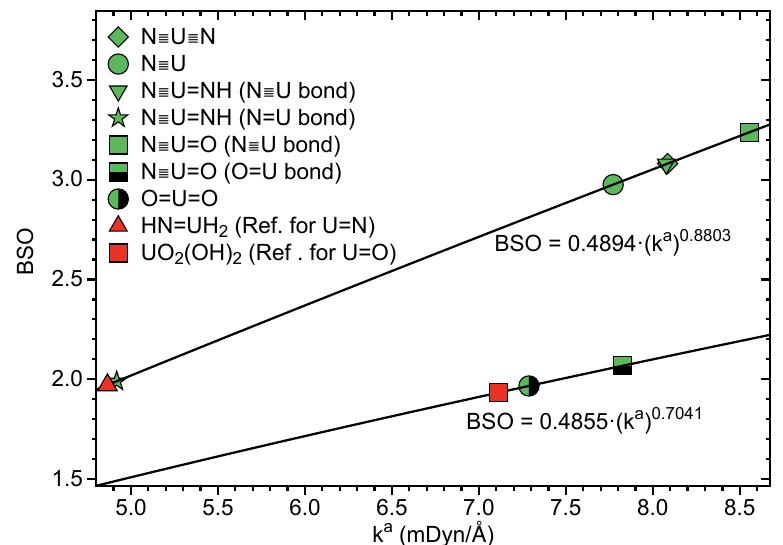
Figure 4. BSO values of UN bonds for the selected uranium nitrides derived from k a values via the power relationship described above. NESCau/PBE0//cc-pwCVTZ-X2C (uranium) and NESCau/PBE0//cc-pVTZ (N,O,H) level of theory.